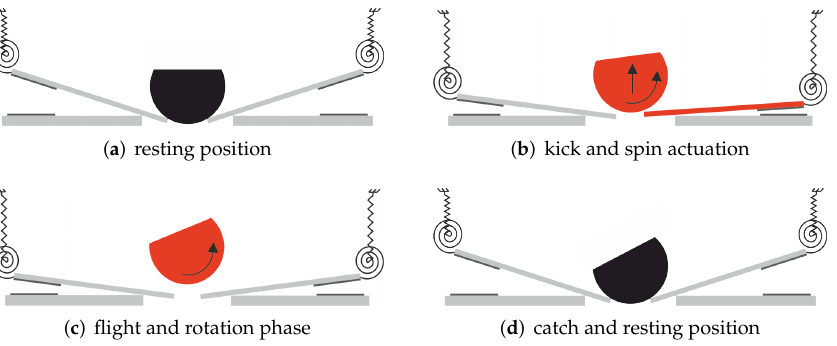
Figure 1. ( a ) Resting position: The sphere remains in stable rest position. ( b ) Kick and spin actuation: The sphere is transferred into a free flight phase, while a torque is transmitted to set it in rotation by asymmetric actuation. ( c ) Flight phase: The sphere is not in contact with the beams and rotates freely into the desired direction. ( d ) Catch and resting: The sphere lands in a deflected position and is kept in a stable